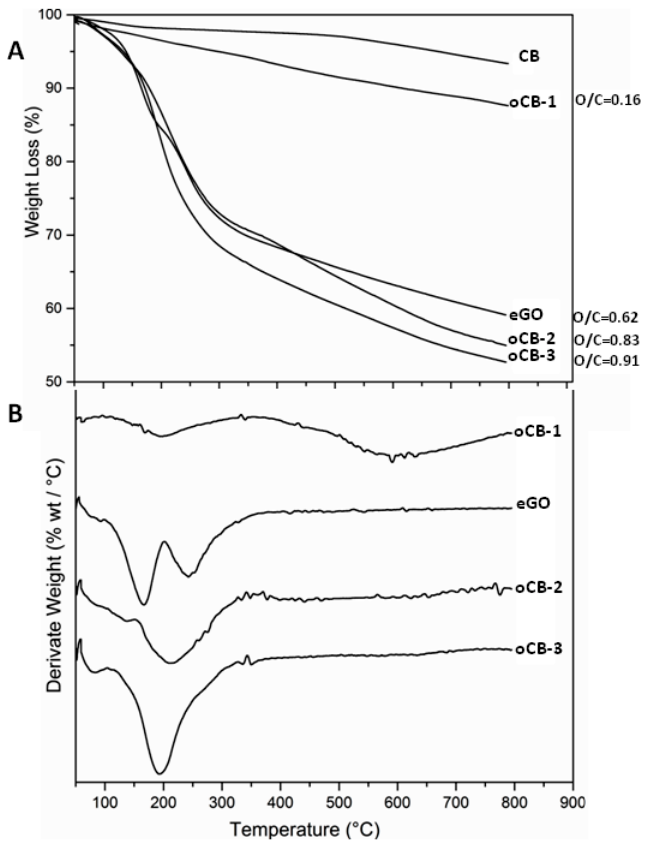
Figure 1. TGA scans at 10 °C/min after drying at 100 °C in the TGA apparatus, of starting Carbon black (CB) and all the considered carbon nanofillers: oCB-1; eGO; oCB-2; oCB-3. ( A ) TGA; ( B ) DTGA. Close to each curve, their O/C molar ratio is indicated.